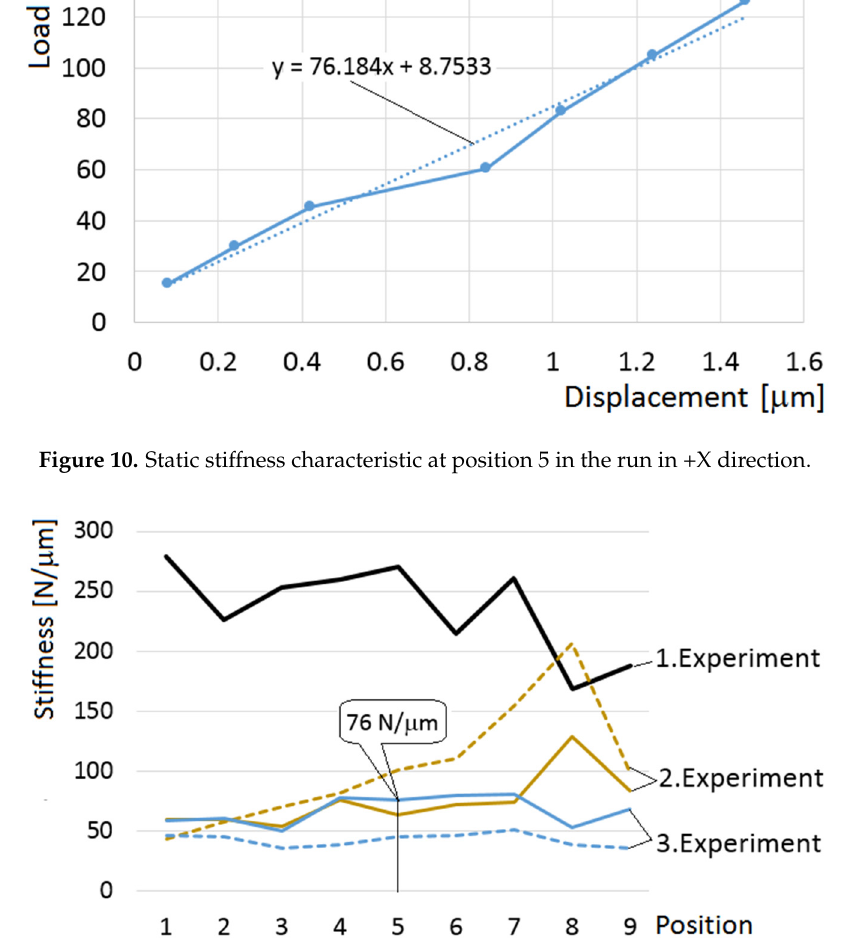
Figure 11. The stiffness course under all three methods with F r force in the +X direction (full line), − X (dotted line).